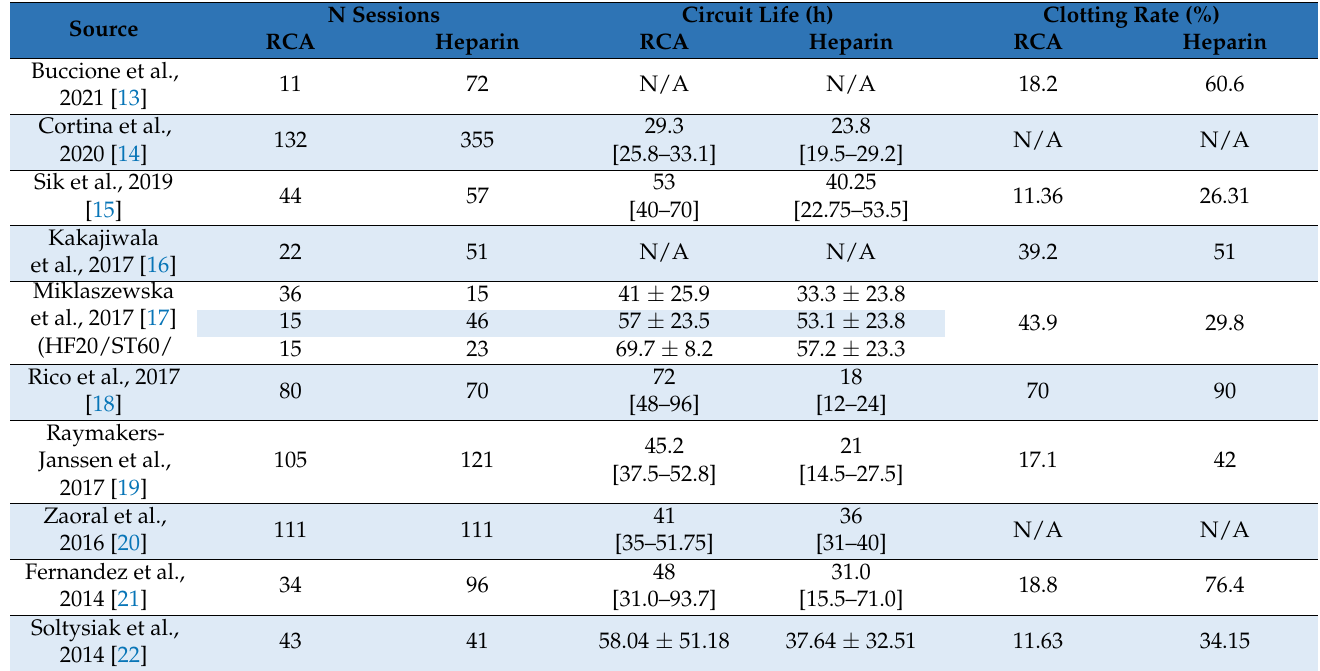
Table 3. Circuit lifetime and clotting rate reported by studies included. RCA: regional citrate anticoagulation.